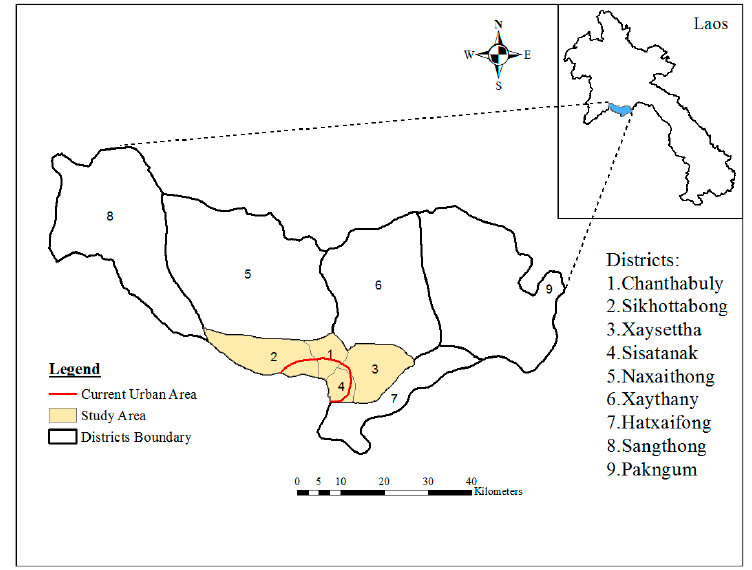
Table 1. Population in the study area districts of Vientiane.